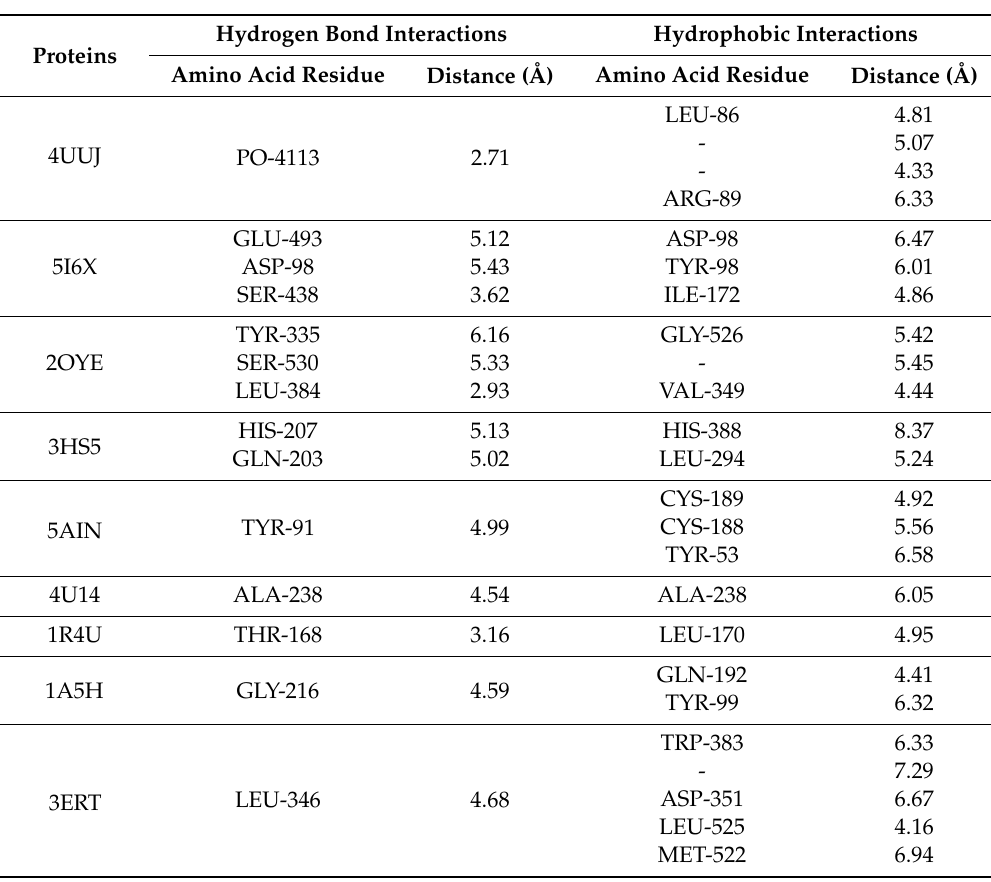
Table 5. Binding interaction of psychotriasine with di ff erent